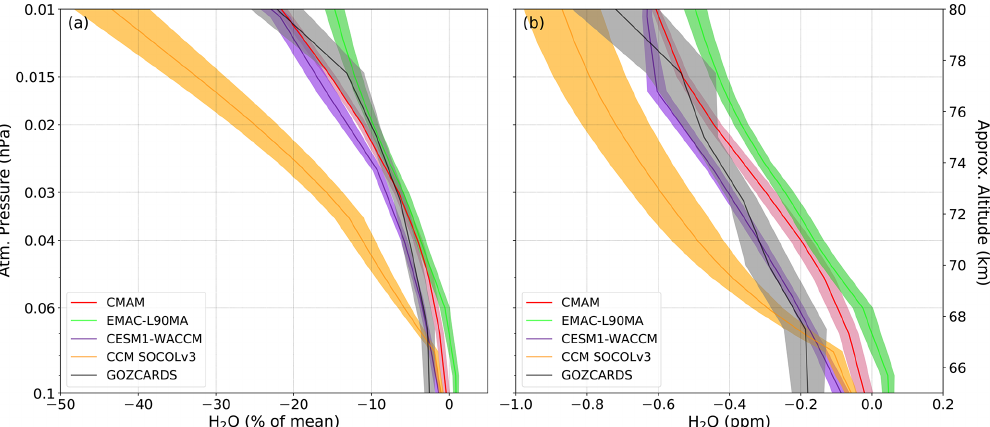
Figure 6. Vertical profiles of solar irradiance response in H 2 O from CCMI-1 models and GOZCARDS observational composite for 1992– 2017 at tropical latitudes (30 ◦ N–30 ◦ S). (a) The relative importance of the solar signal in H 2 O presented as a percentage of the mean. (b) H 2 O regression coefficient at the solar proxy ( β ) in mixing ratio (ppmv). Shadings indicate the standard deviation.